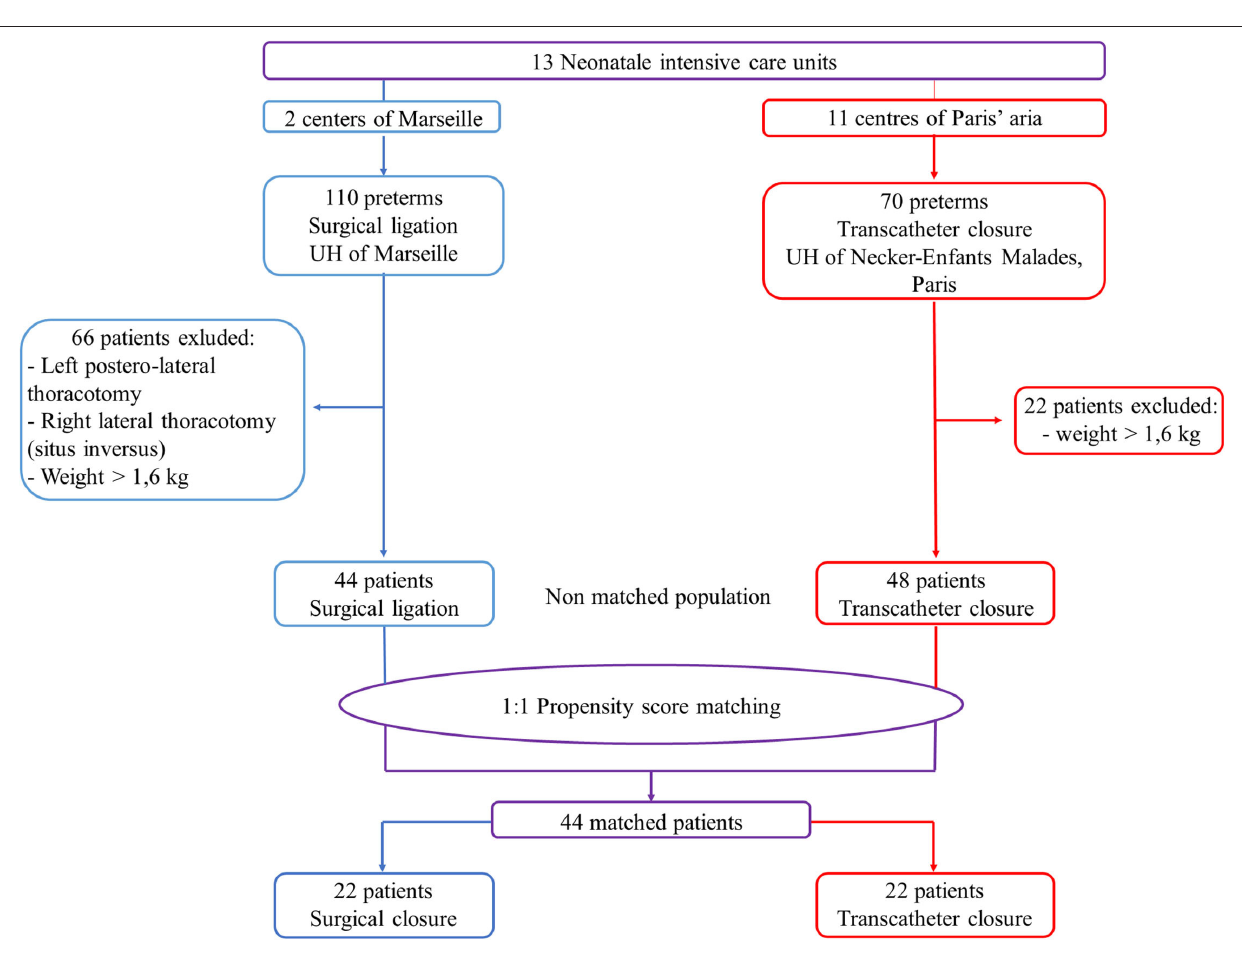
Frontiers in Pediatrics |